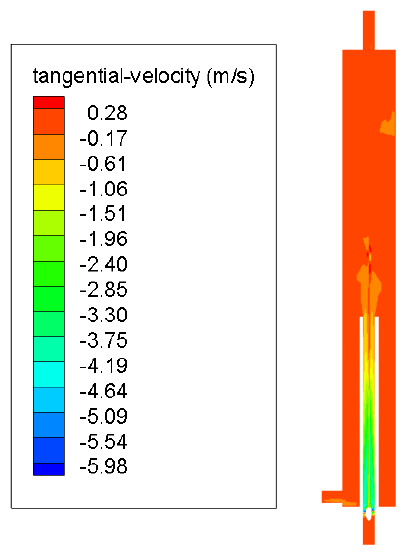
Figure 14. Separator internal tangential velocity distribution cloud.